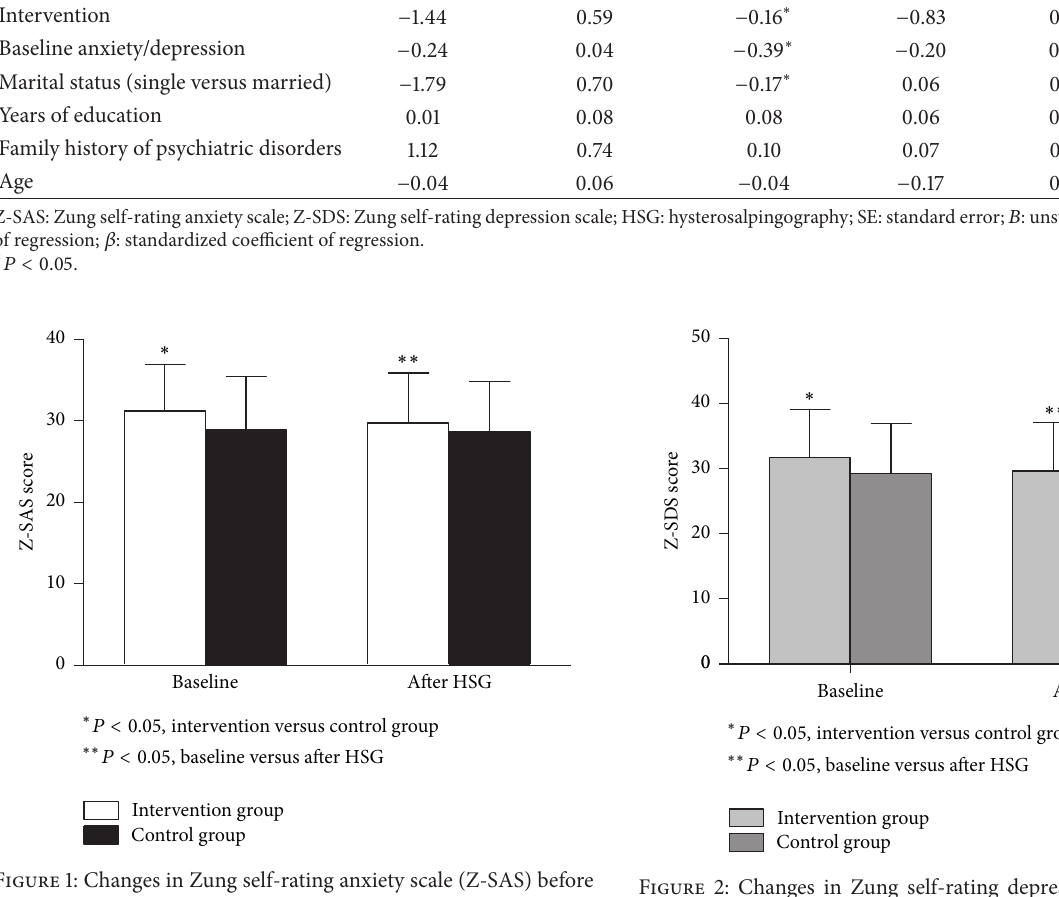
Figure 2: Changes in Zung self-rating depression scale (Z-SDS) before and after hysterosalpingography (HSG) in the intervention andthecontrolgroups.Scoresabove40identifyclinicallysignificant